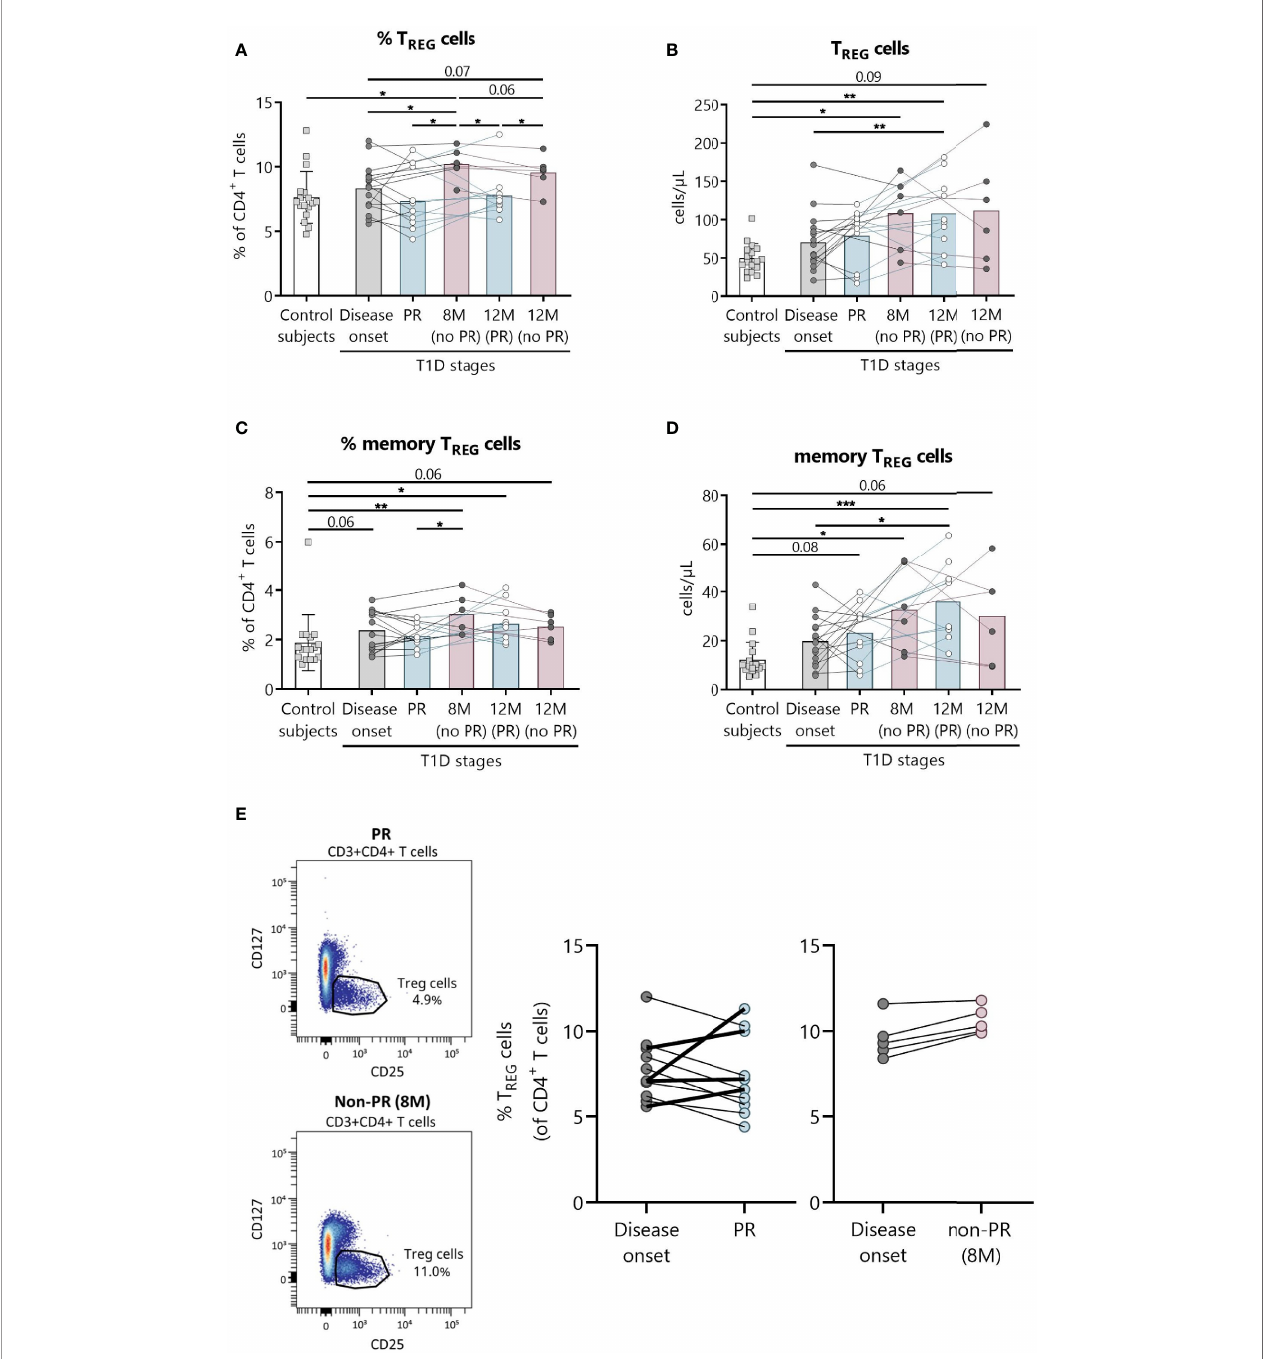
FIGURE 3 | Peripheral blood T REG are quantitatively altered at the initial stages of T1D. Percentages (%) and concentrations (cells/µl) of (A, B) T REG and of (C, D) memory T REG were determined in peripheral blood of controls and patients with T1D at different time-points. Squares represent controls ( n = 17) (white bar), and patients are represented by light gray dots at disease onset ( n = 16) (gray bar), white dots during PR ( n = 11) and for remitter patients at 12 months (12 M PR) ( n = 10) (blue bars), and dark gray dots for non-remitter patients at 8 months (8 M no PR) ( n = 6) and 12 months (12 M no PR) ( n = 6) (pink bars). (E) Representative plots for the difference in the T REG percentage between PR and non-PR (8 M), and changes in this cell population from the disease onset to the PR phase or non-PR (8 M). Bar graphs show mean percentage or absolute count values. Each symbol represents an individual patient. Lines link the same patient throughout the time- points. * P ≤ 0.05, ** P < 0.01, *** P < 0.001 after mixed effects model with Tukey ’ s post-hoc test for longitudinal data, Kruskal – Wallis with Dunn ’ s post-hoc test for comparisons between control subjects and the different T1D time-points, or 2-tailed Mann – Whitney test for comparisons between two unpaired groups of data. P ≤ 0.05 is considered signi fi